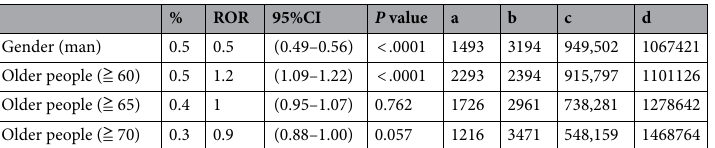
Table 2. Relationships of antibiotic-induced taste and smell disorders with gender and age. a: Number of cases of taste and smell disorders in older males. b: Number of cases of taste and smell disorders in younger females. c: Number of other AEs in older males. d: Number of cases of other AEs in younger